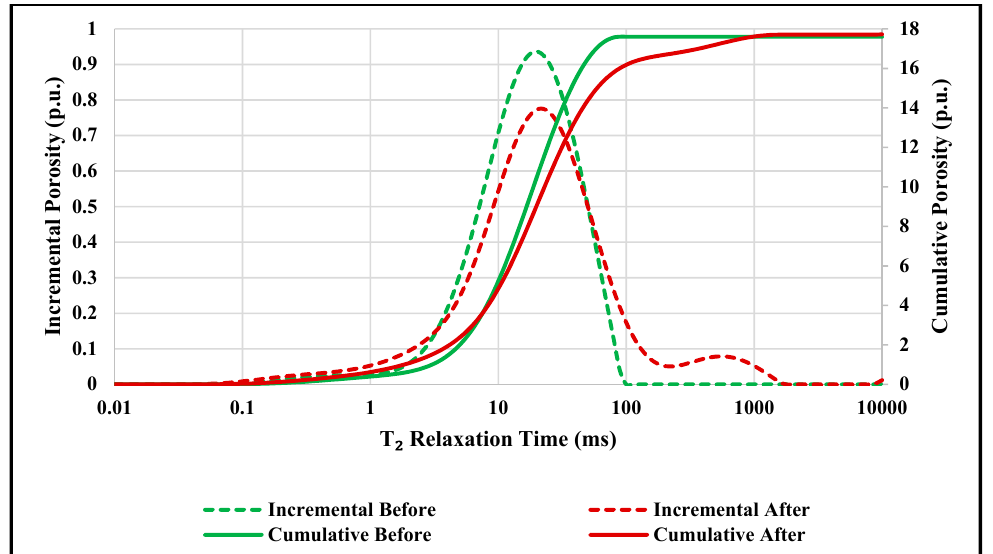
Figure 8. Incremental and cumulative porosity distribution for the sample before ( green ) and after ( red ) thermochemical injection.